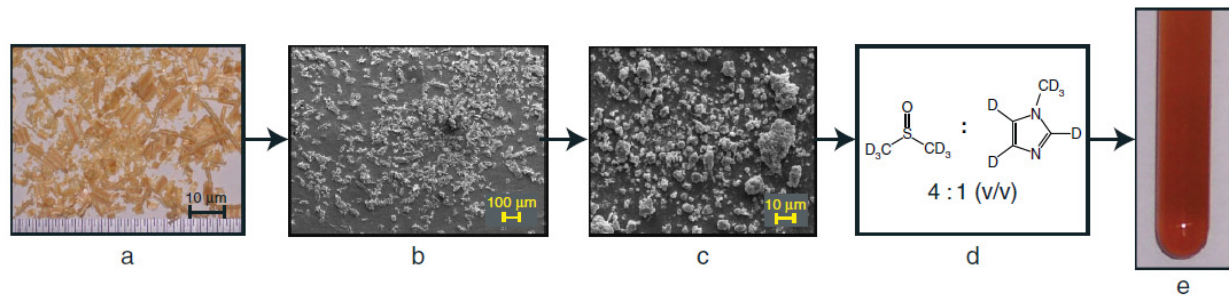
Figure 10. A diagram illustrating the nonderivatized dissolution of plant cell walls. Pinus taeda is shown here as an example: ( a ) shavings produced via a conventional planer; ( b ) cryogenically mixer-milled; ( c ) planetary ball-milled; ( d ) dissolution method; ( e ) NMR tube of cell walls in solution (Reprinted from [75]. Copyright 2008